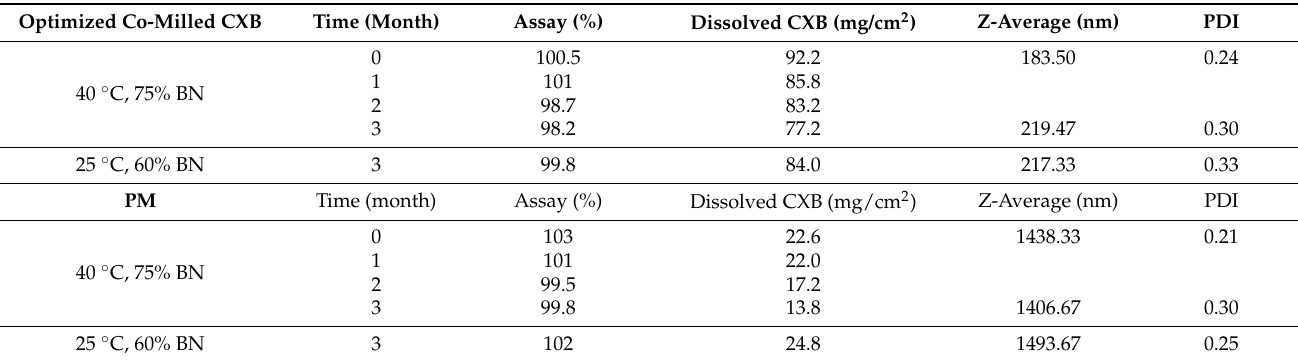
Table 8. Stability results of optimized co-milled celecoxib and physical mixture at 40 ◦ C, 75% RH and 25 ◦ C, 60%